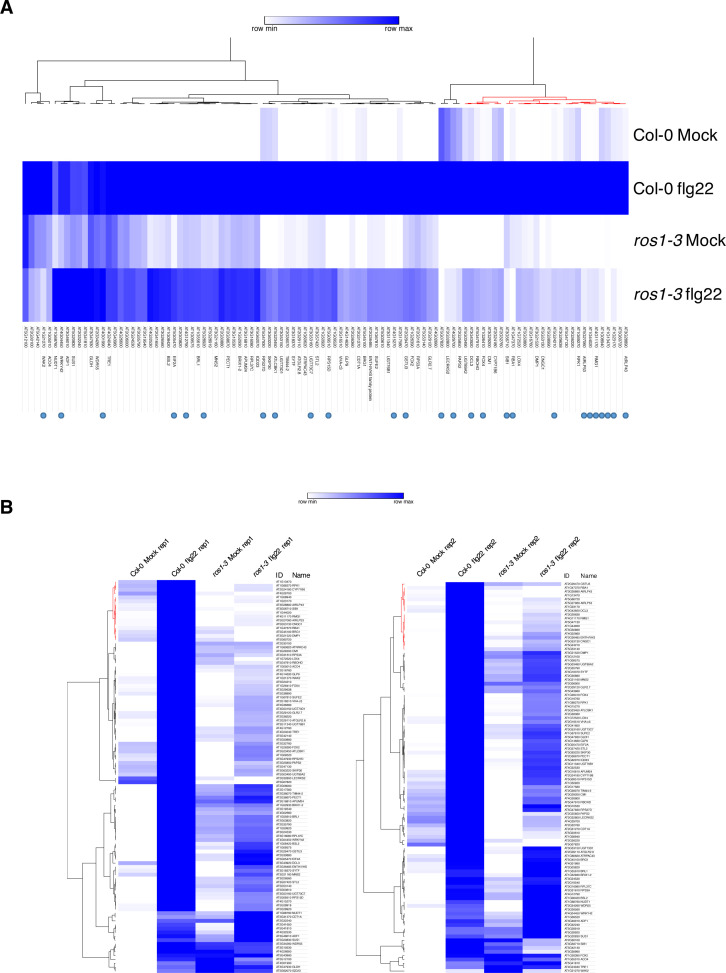
RNA sequencing experiment in 5-week-old rosette leaves of Col-0 and ros1-3 syringe-infiltrated with either mock or flg22 for 6 hr.(A) Heatmap depicting the relative expression of the 102 less-induced genes in Col-0 and ros1-3 mutants upon 6 hr of mock or flg22 treatments. AGI numbers and gene names are shown for all individual gene. Merged data from two independent biological replicates are presented. (B) Heatmaps showing the relative expression of the 102 less-induced genes for each independent biological replicate.